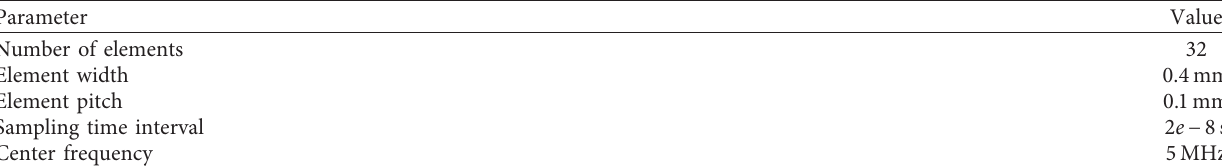
Figure 4: The geometry of two-layer structure. (a) Model 1. (b) Model 2. (c) Model 3. Table 1: The specifications of the ultrasonic phased